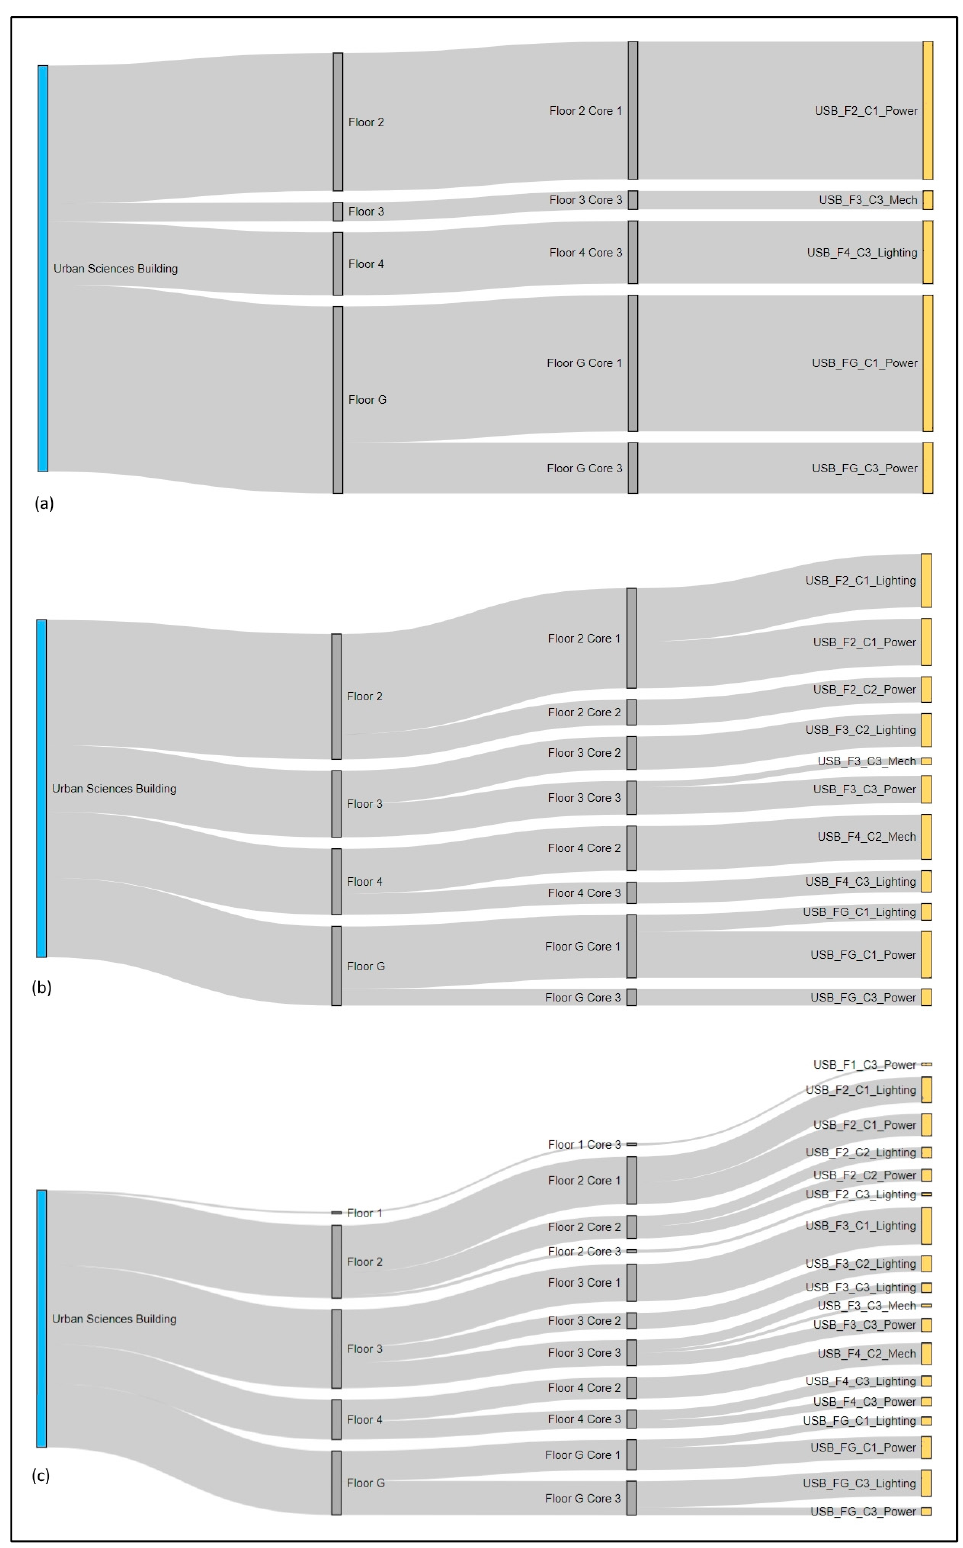
Figure 11. Three snapshots, with a time-lapse of approximately 5 s, of an evolving visualisation of the flow of electricity through the Urban Science Building from state (a) to (b) and then (c); in real-time, the visualisation is updated each second.